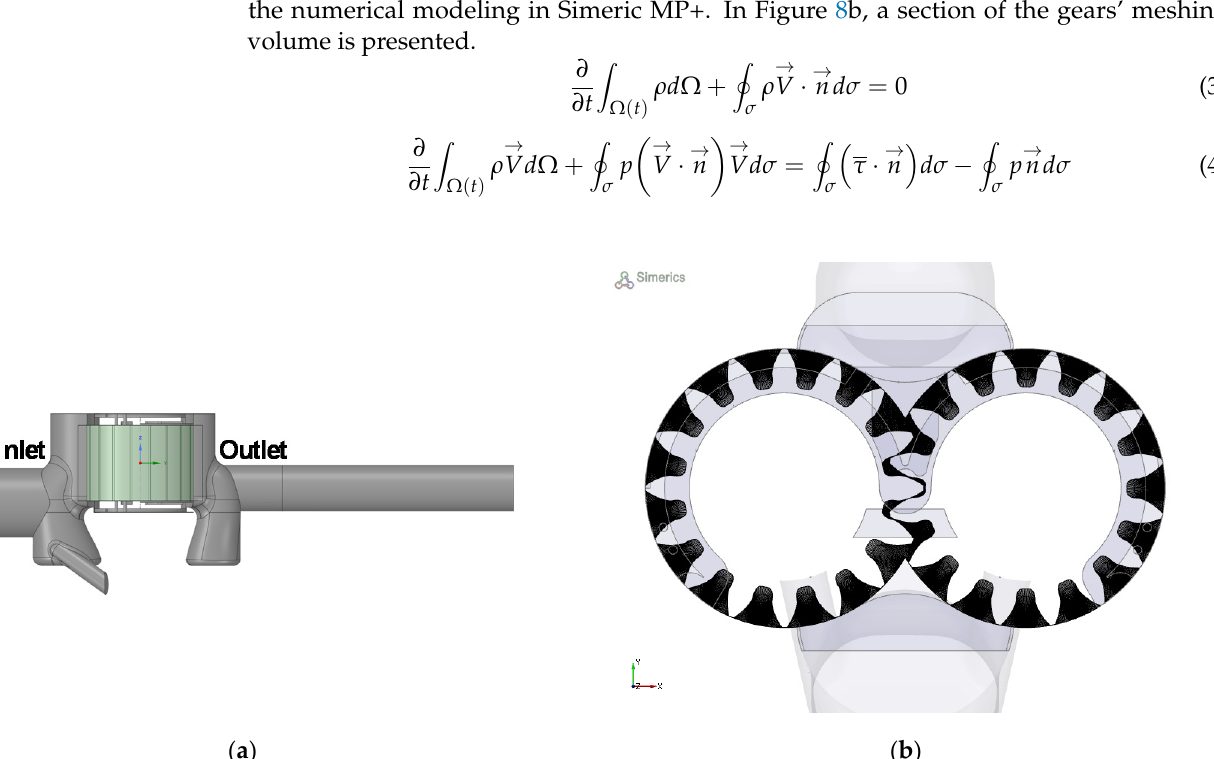
Figure 8. Three-dimensional CFD numerical model: ( a ) Extracted fluid volume; ( b ) the mesh in the meshing volume.